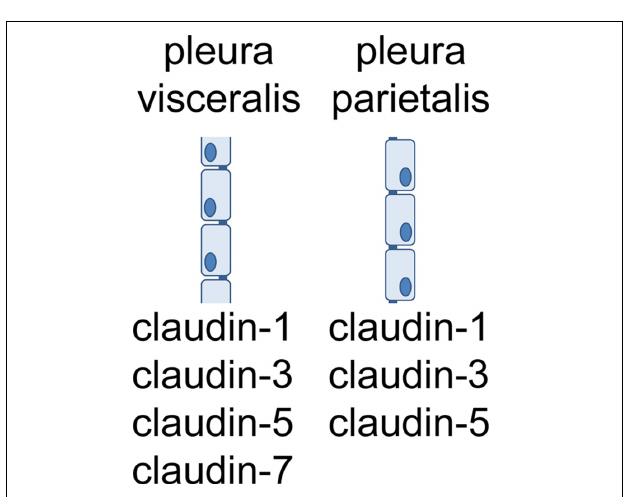
FIGURE 4 | Claudins of visceral and parietal